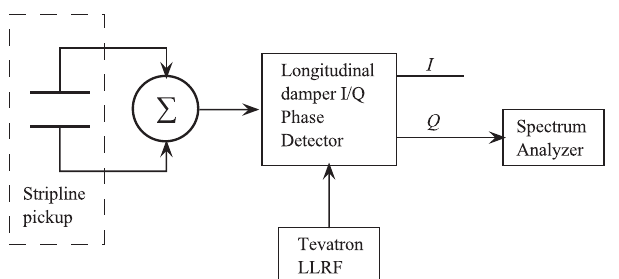
FIG. 3. The block diagrams of the bunch phase modulator and detectors used to monitor the bunches for the described experi- ments.